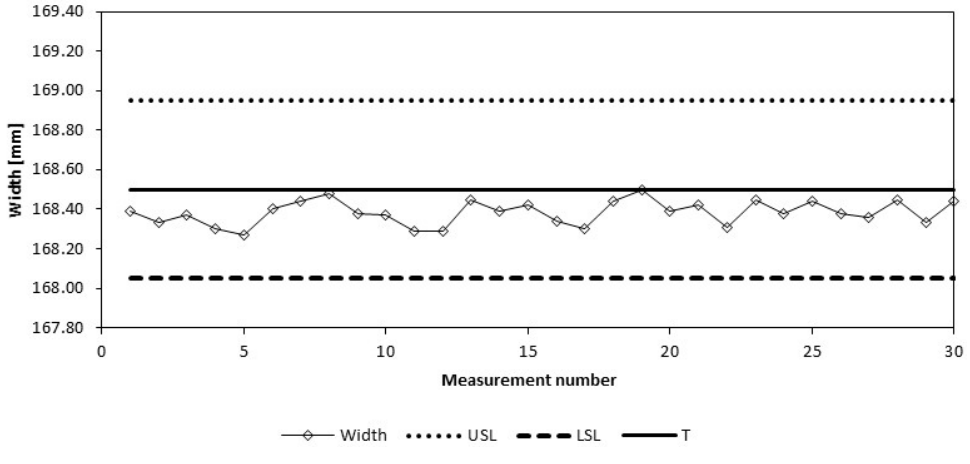
Figure 6. Measured data of the width parameter, second day.